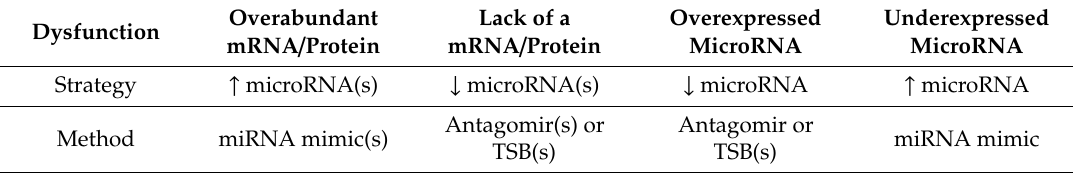
Table 2. The basis of miRNA-targeting therapeutic